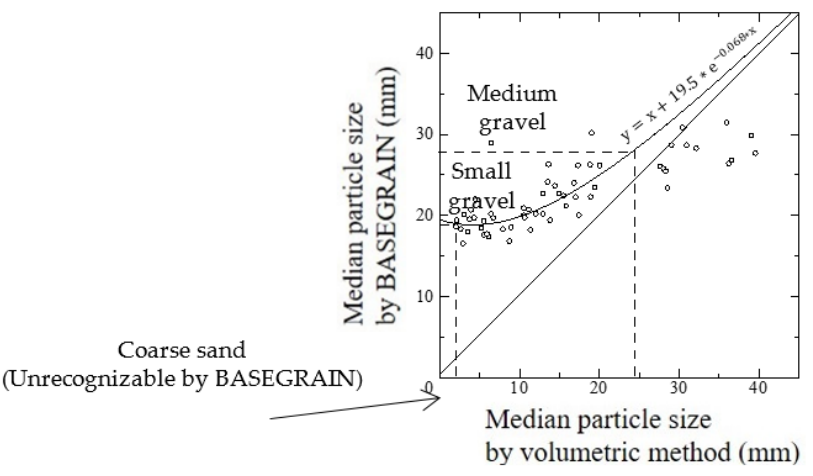
Figure 7. Comparison between results for the BASEGRAIN and volumetric methods.